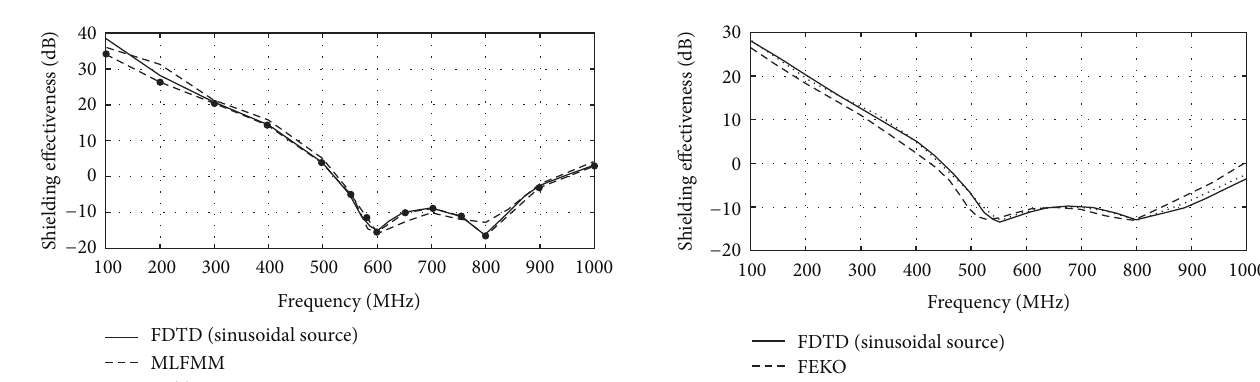
12cm 2 illuminated with ×